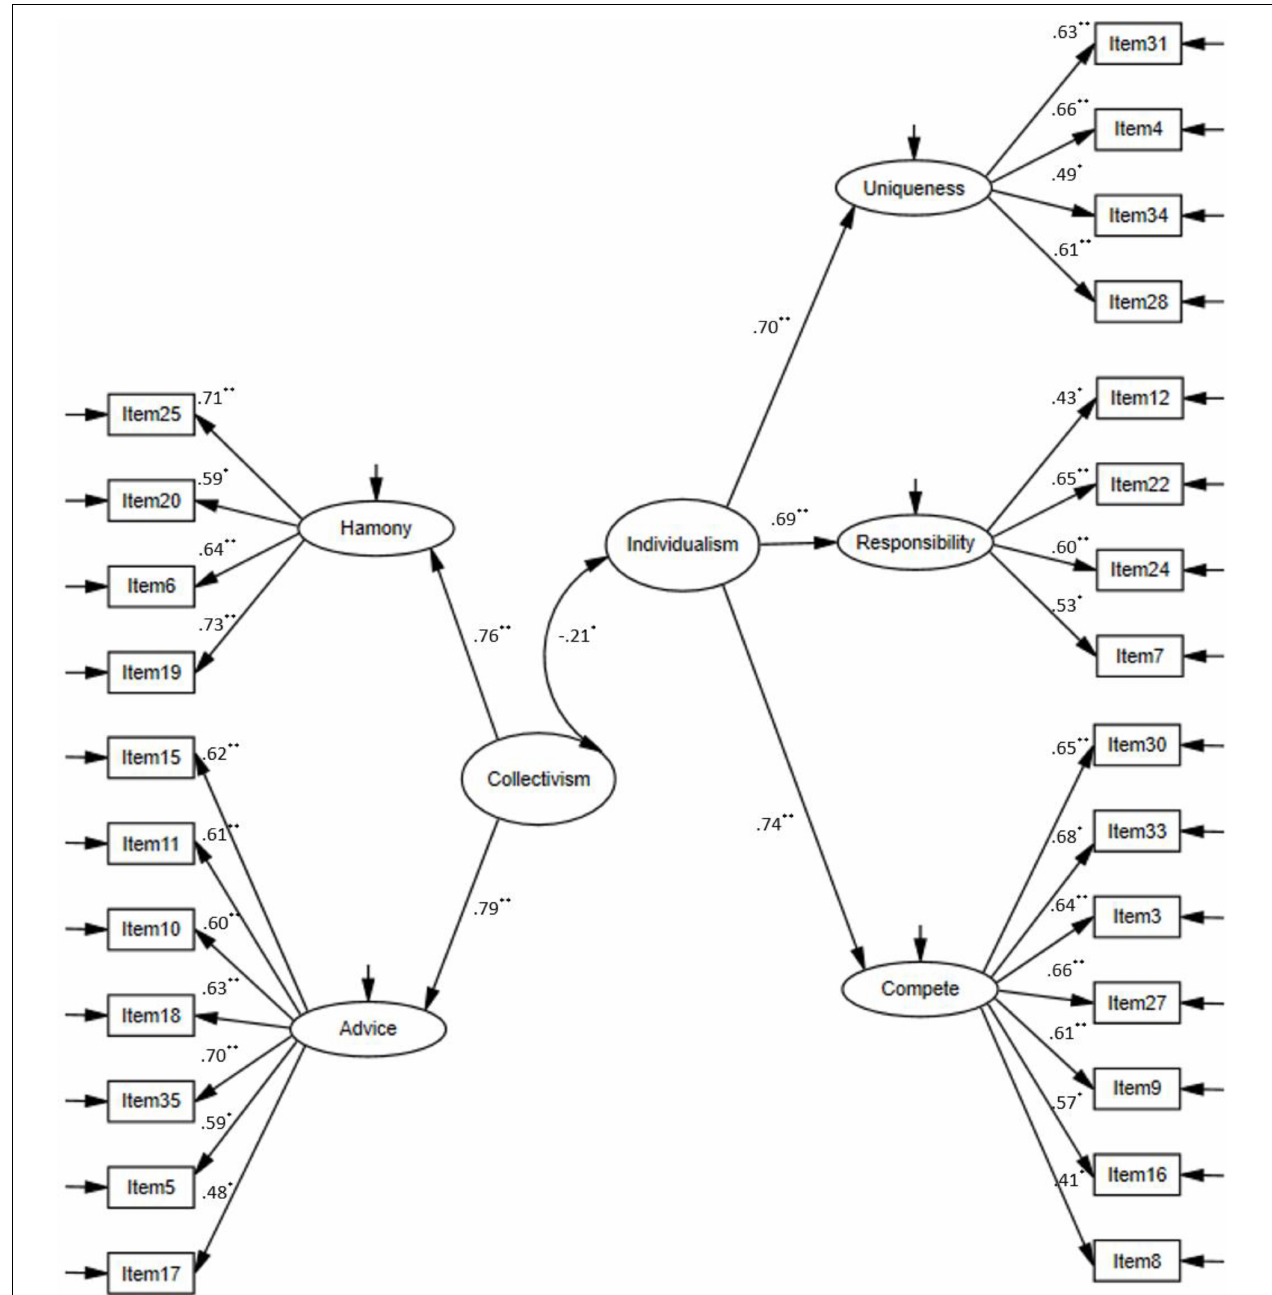
FIGURE 1 | The factor structure, standardized regression weights, and correlation coefficients of the AICS; * p < 0.05; ** p < 0.01; item details are available in Shulruf et al. (2011b, p. 65).